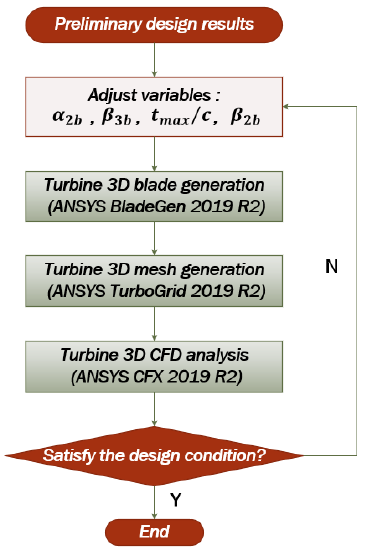
Figure 9. Flow chart of the blade optimization for one stage of the radial outflow turbine.